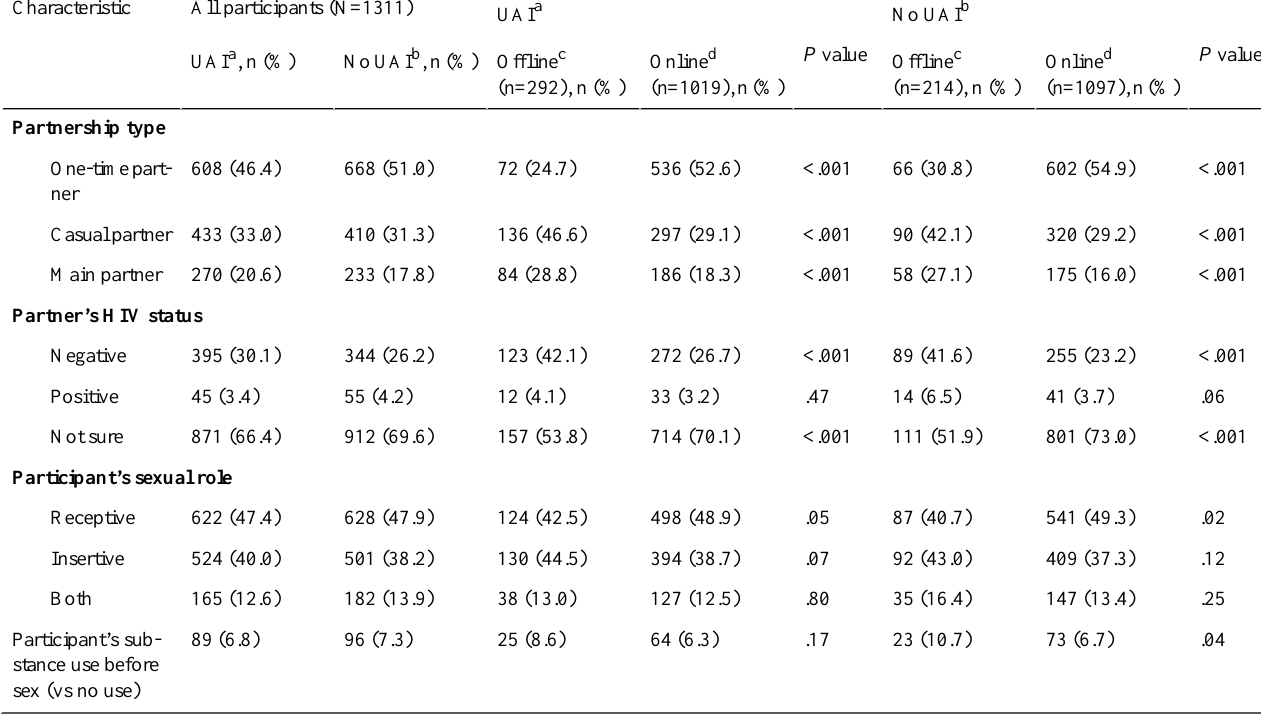
Table 2. Interval-level characteristics of sexual acts among 1311 adult Blued app users in 4 provinces in China who reported engaging in both unprotected and protected anal sex in the past 6